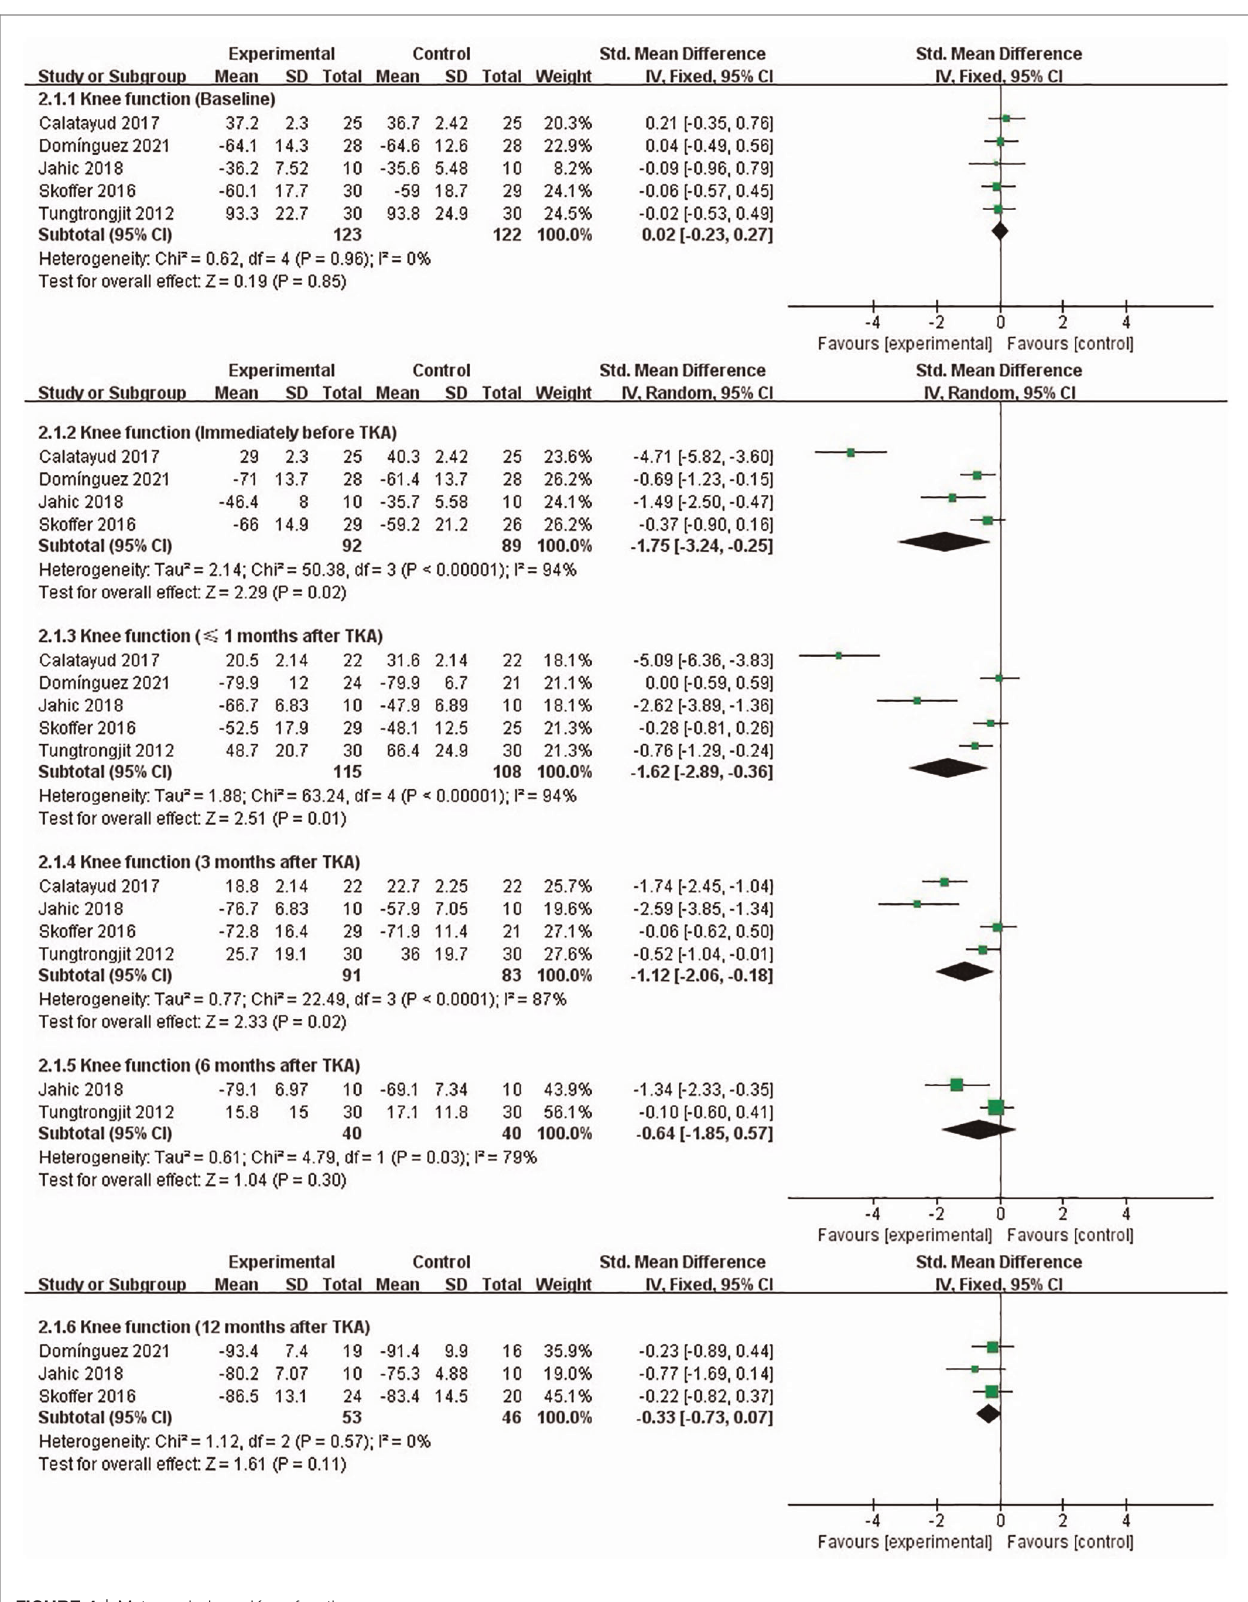
FIGURE 4 | Meta-analysis on Knee